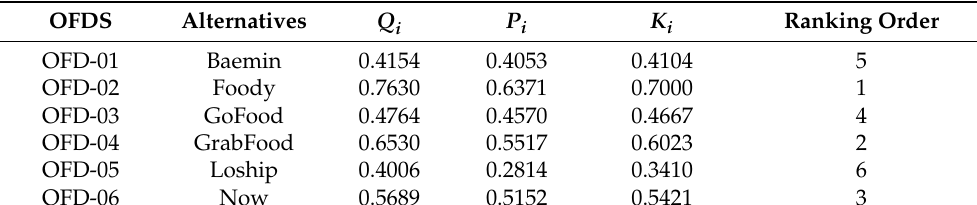
Table 11. The aggregated utility function value of WASPAS model.